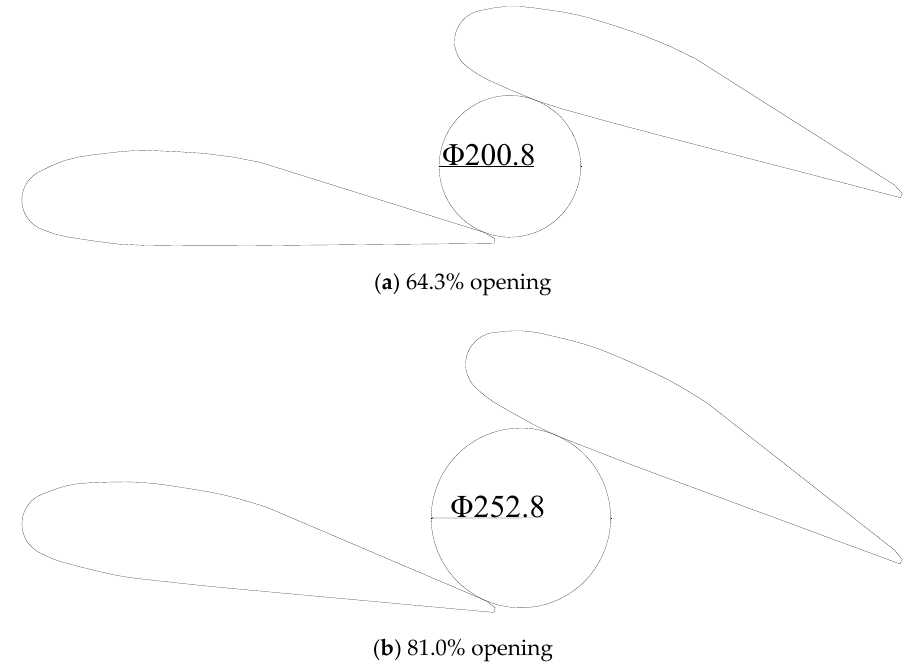
Figure 2. Guide vane surface model.